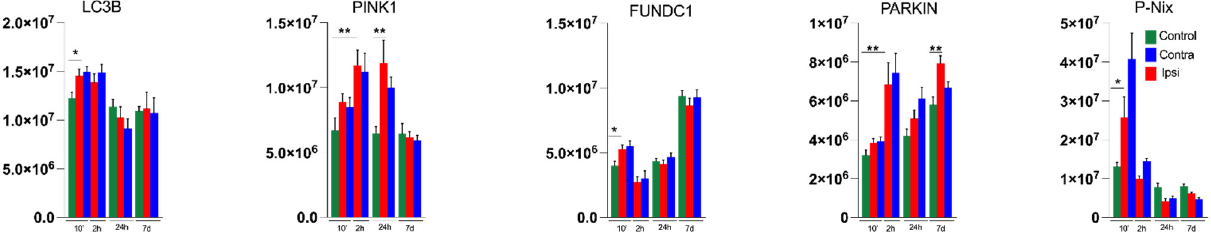
Figure 11. Quantification of mitophagy-related proteins after HI n = 6–8/gp +/− SEM. * p ≤ 0.05, ** p ≤ 0.01. Statistics compared by Mann–Whitney Test between the control and respective ipsilateral